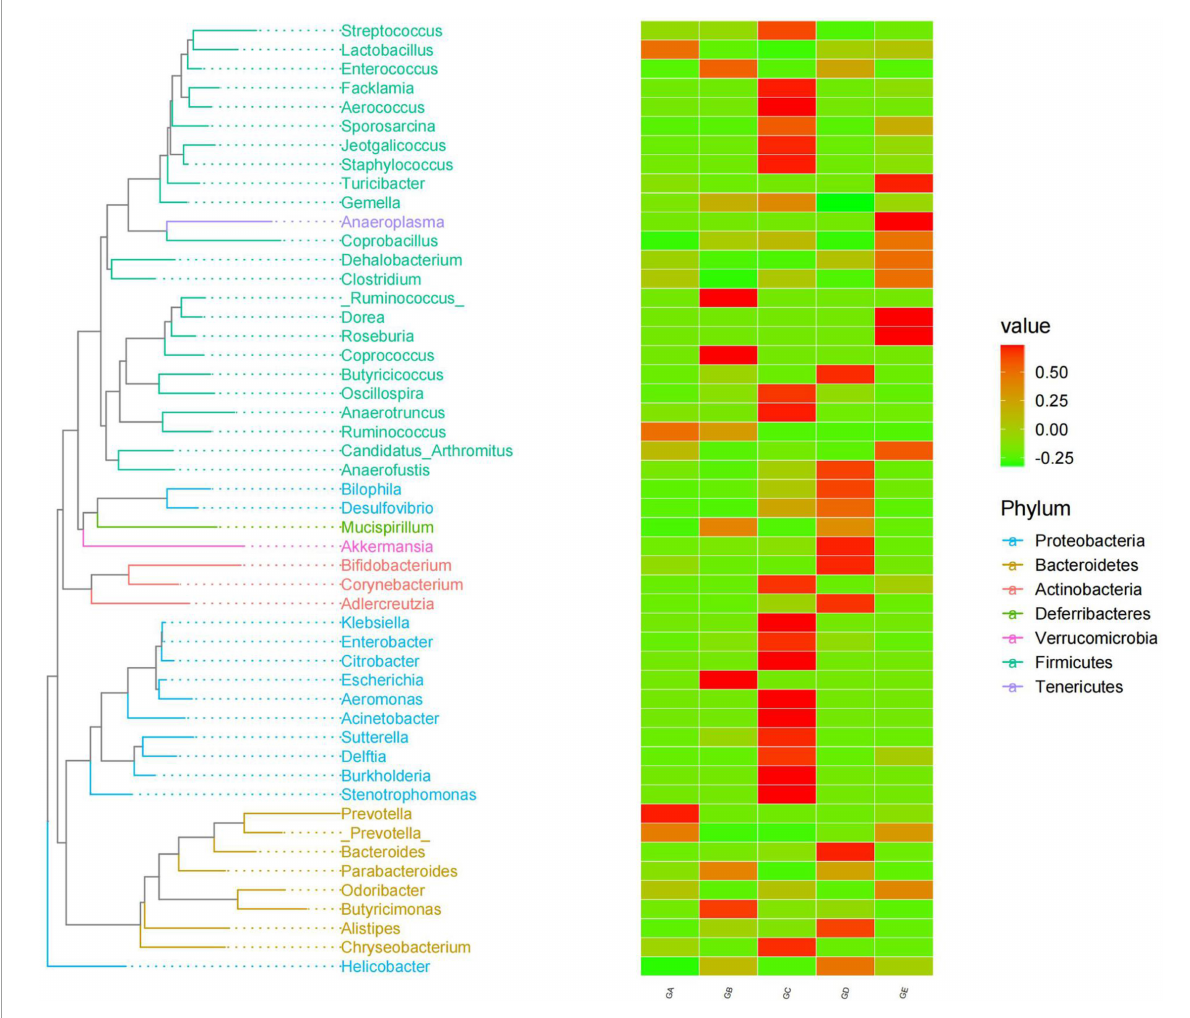
FIGURE6 BLBP partly restored the gut microbiota in mice induced by LPS through phylogenetic analysis of the top 50 abundance-specific